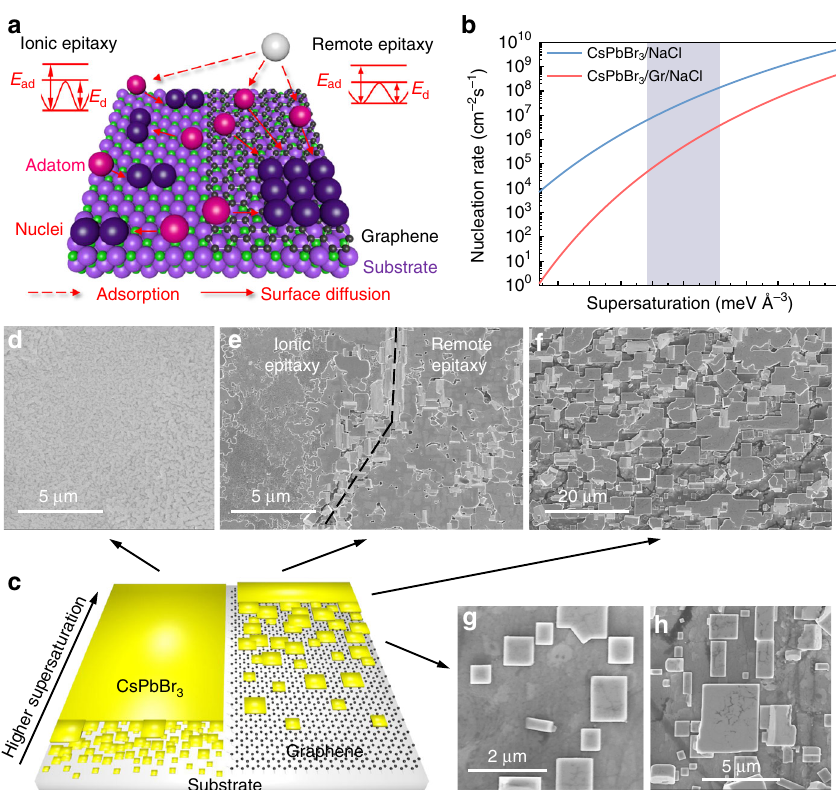
Fig. 3 Growth kinetics of ionic and remote epitaxy. a Schematic illustration of atomistic nucleation process at the initial stages of both ionic and remote epitaxy. b Nucleation rate as a function of supersaturation for both ionic epitaxy (CsPbBr 3 /NaCl) and remote epitaxy (CsPbBr 3 /Gr/NaCl). c Schematic illustration of the nucleation process at the fi nal stages of both ionic and remote epitaxy. d – h SEM images of speci fi c interesting regions on a typical sample denoted by black